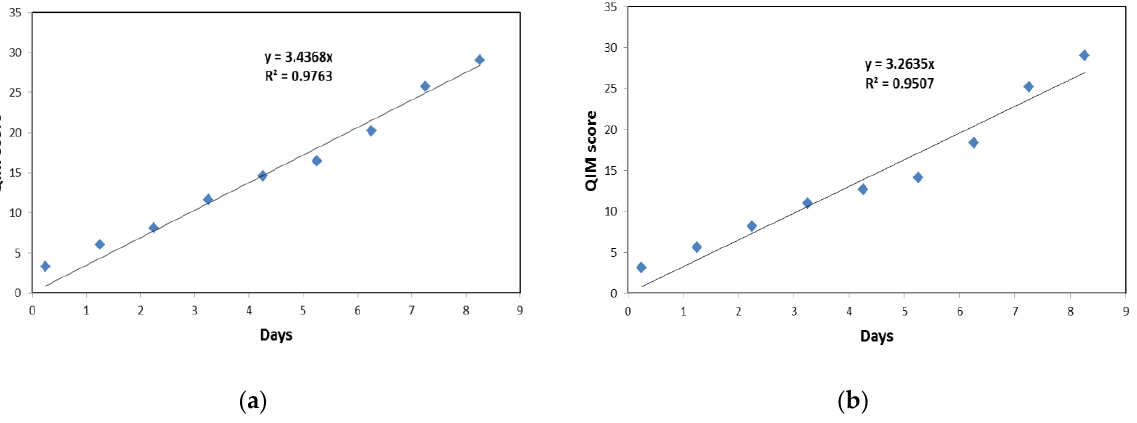
Figure 2. Linear QIM models for ( a ) traditional fish handling practice and ( b ) modified fish handling practice using pumps and isothermic boxes.